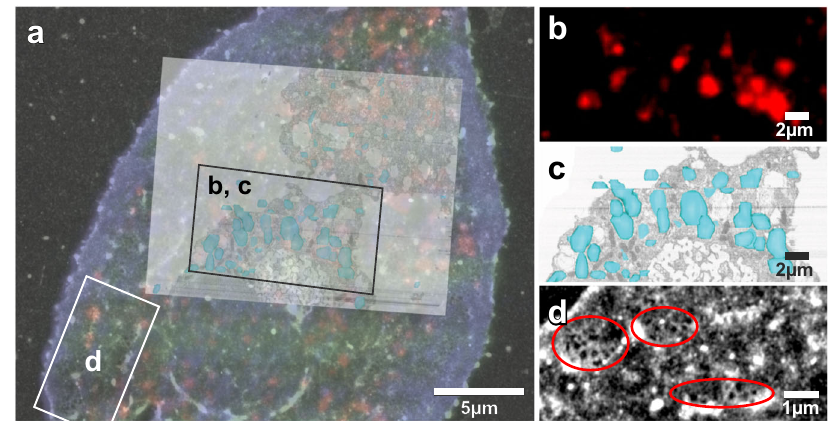
Fig. 3 Chip-based TIRF and dSTORM imaging combined with FIB-SEM of LSECs, sample 1. a Chip-based TIRF and dSTORM overlay of a LSEC including a correlation to the corresponding FIB-SEM datastack. b Chip-based TIRF showing AF488-FSA (in red) internalized in vesicles upon 2 h incubation with the cells. c 3D reconstruction of lysosomes based on the FIB-SEM datastack and the x / y re-sliced imaging plane (manually segmented in light blue). d chip- based dSTORM of the cell surface displaying fenestrations (in encircled areas).